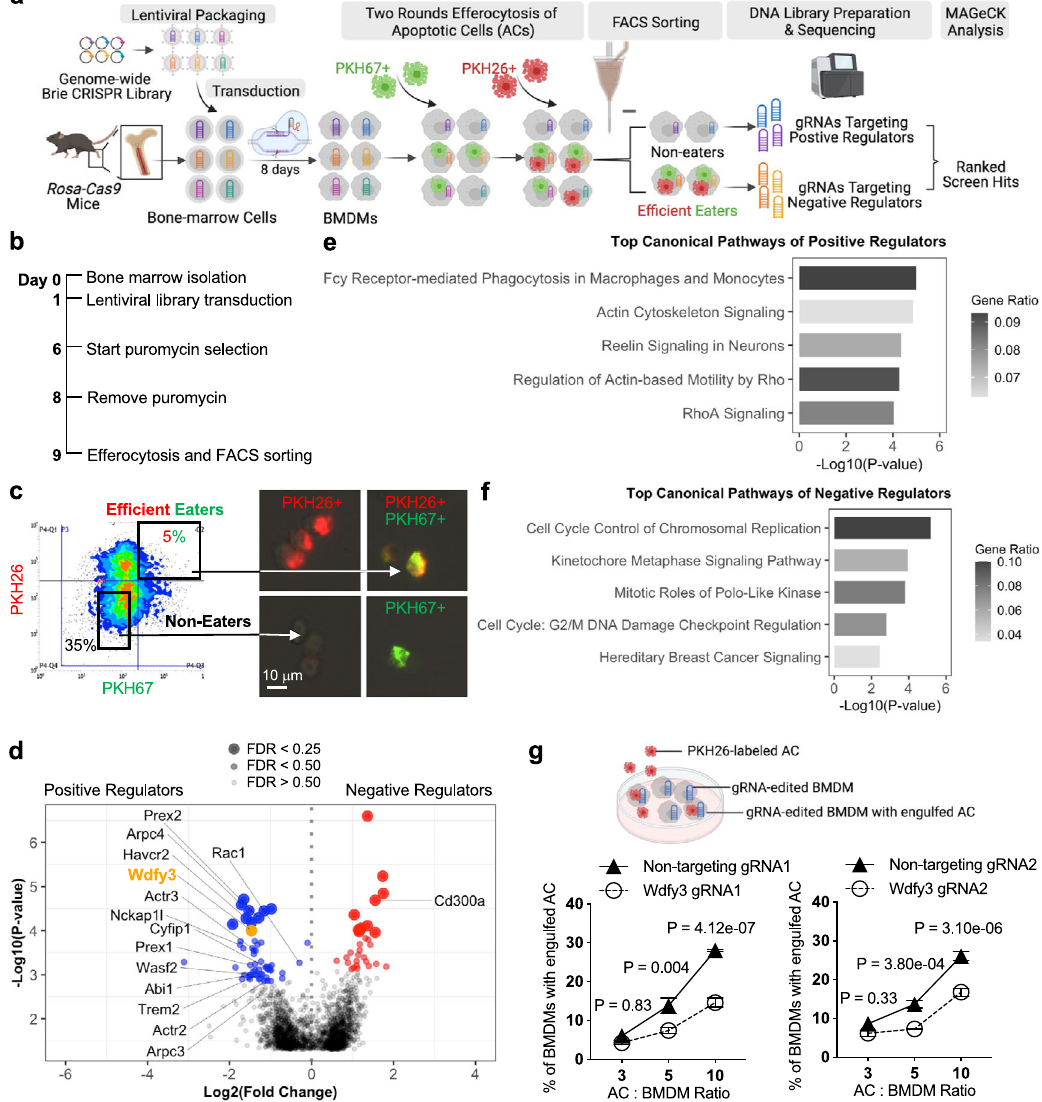
Fig.1|Apooled, fl uorescence-activatedcellsorting(FACS)-basedgenome-wide CRISPRknockoutscreeninprimarymousemacrophagesidenti fi edknownand novel regulators of macrophage efferocytosis. a Schematics of the CRISPR screen work fl ow. b Timeline of bone marrow isolation, lentiviral library transduc- tion, puromycin selection, efferocytosis, and cell sorting. c Visualization of gating strategyforseparationofnon-eatersandef fi cienteaters.Successfulseparationwas con fi rmed by fl uorescent microscopy. d Volcano plot highlights the top-ranked screen hits that are known positive and negative regulators of macrophage